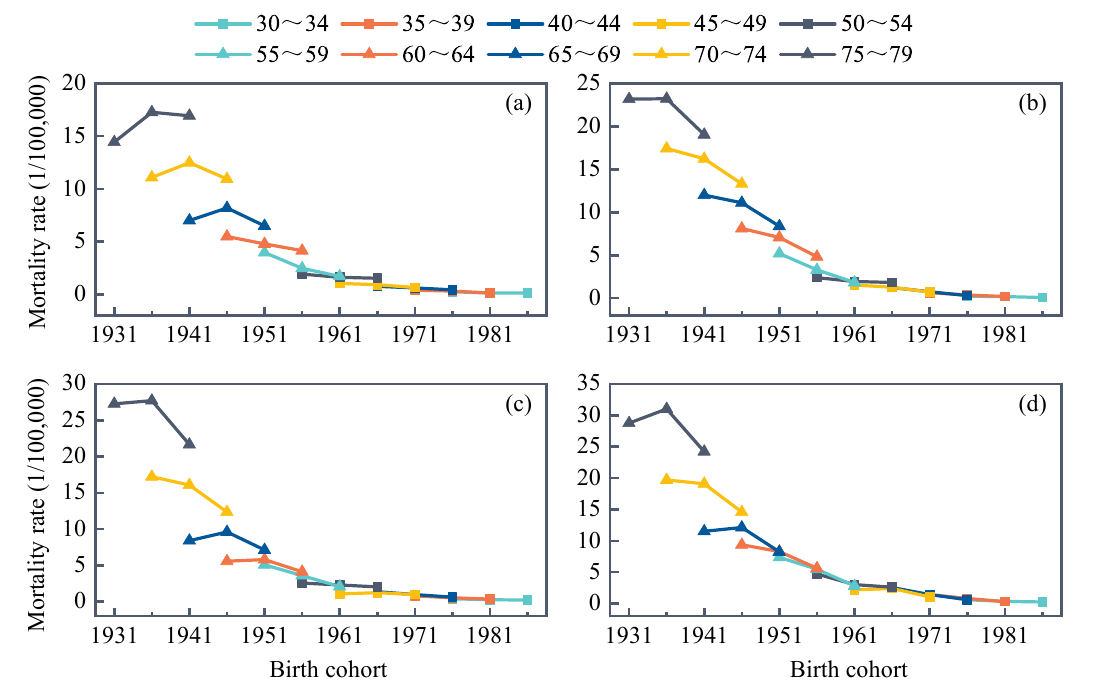
Figure 4. Mortality rates of RHD in China among those aged 30 to 79 years. Mortality data were collected from the Disease Surveillance Points system of China. Birth cohorts analyses were from 1931 to 1990, with every 5–year interval as one cohort. ( a ) Urban male, ( b ) urban female, ( c ) rural male, ( d ) rural